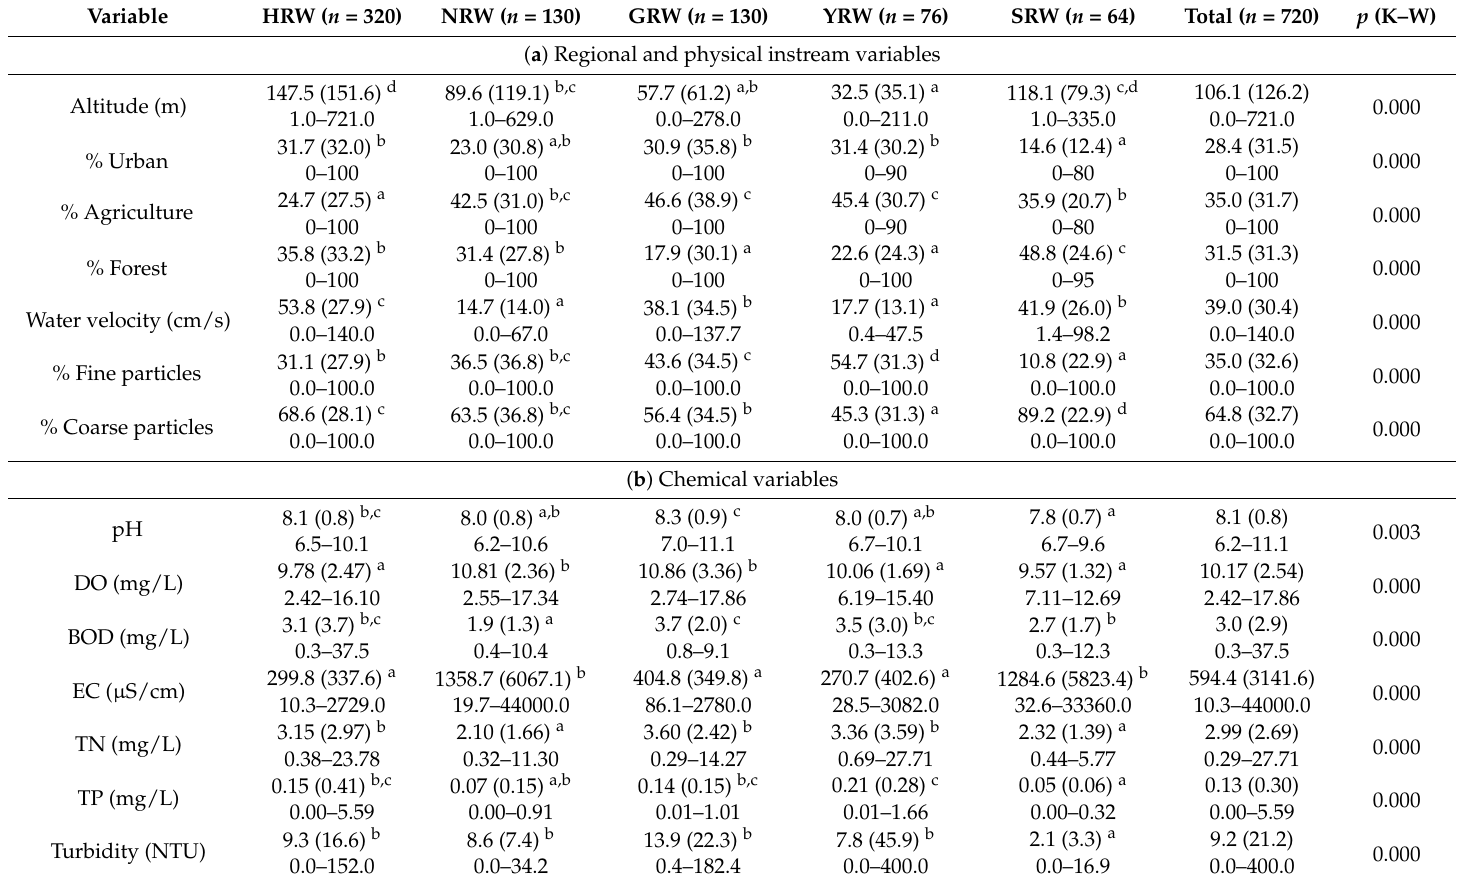
Table 1. Descriptive statistics of ( a ) regional and physical instream variables and ( b ) chemical variables in the five major river watersheds: the Han River (HRW), Nakdong River (NRW), Geum River (GRW), Youngsan River (YRW) and Seomjin River Watershed (SRW). Top and bottom lines of each variable indicate the average with standard deviation (in parenthesis) and the range, respectively. Kruskal–Wallis test (K–W) was performed with the environmental variables to compare the differences of each variable among river watersheds. The same small letters indicate no significant difference based on Dunn’s multiple comparison tests. Abbreviations: DO, dissolved oxygen; BOD, biochemical oxygen demand; EC, electrical conductivity; TN, total nitrogen; TP, total